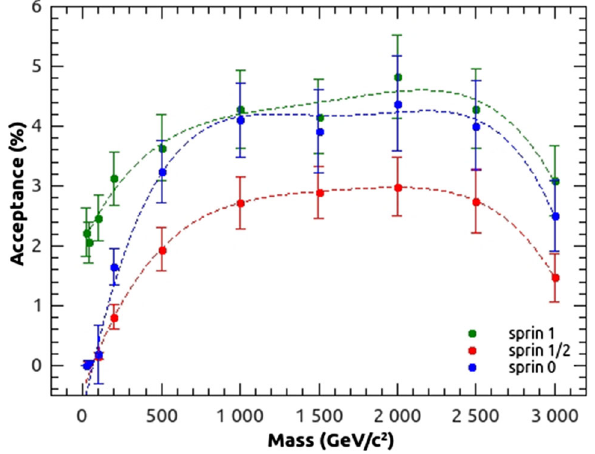
Fig. 13 Acceptance for monopole pair production with magnetic charge 2 g D. The dashed lines represent 4th order polynomial fits to the data